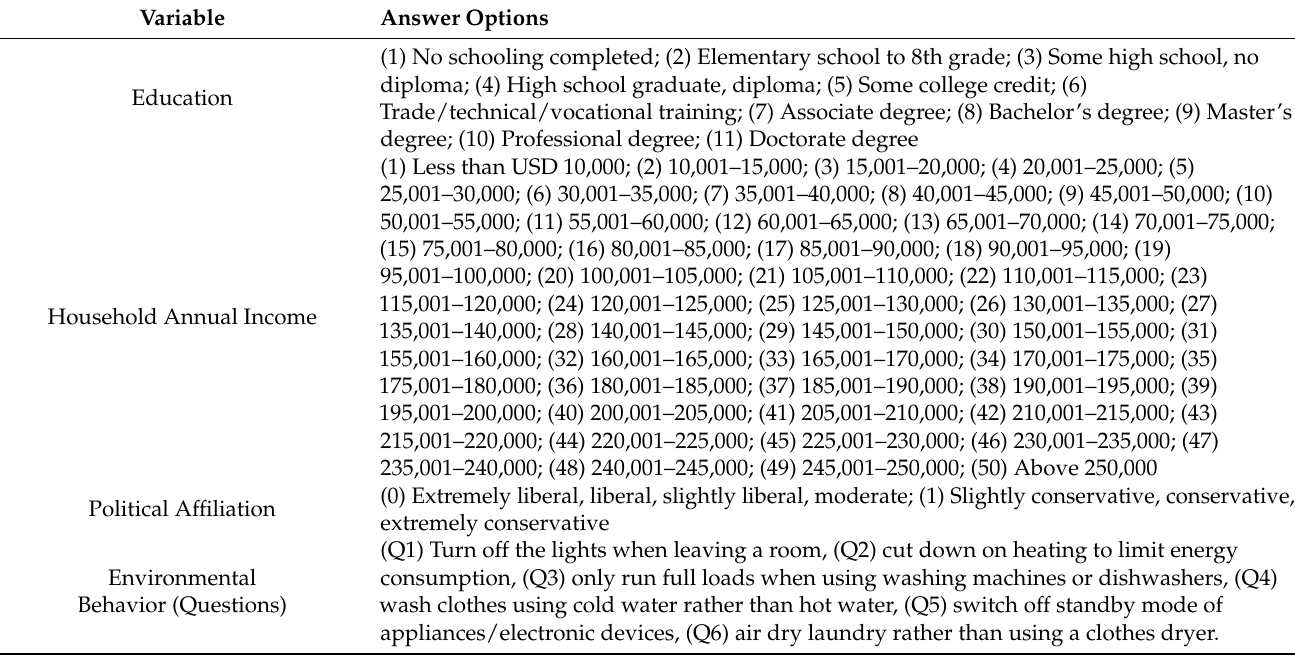
Table A1. Survey Question Details for Some Explanatory